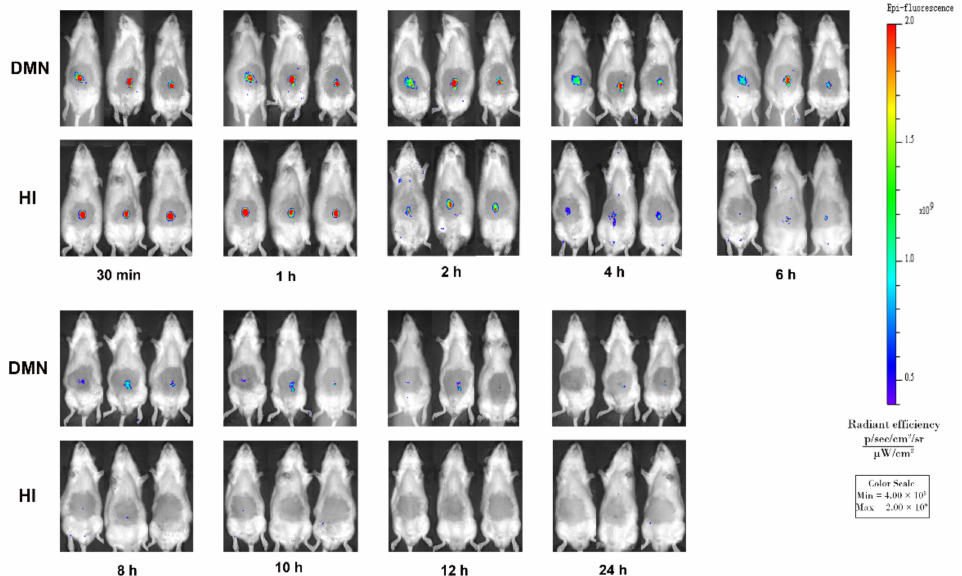
Figure 9. In vivo fluorescence intensity images of SD rats after application of rhodamine B via dissolving MNs or hypodermic injected ( n =